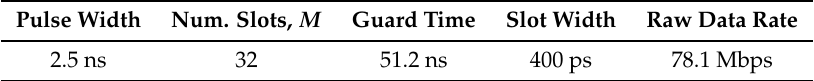
Table 4. Optical communication parameter set that was investigated. The guard time was selected to close the LEO to Earth optical link. The corresponding raw data rate was calculated from Equation